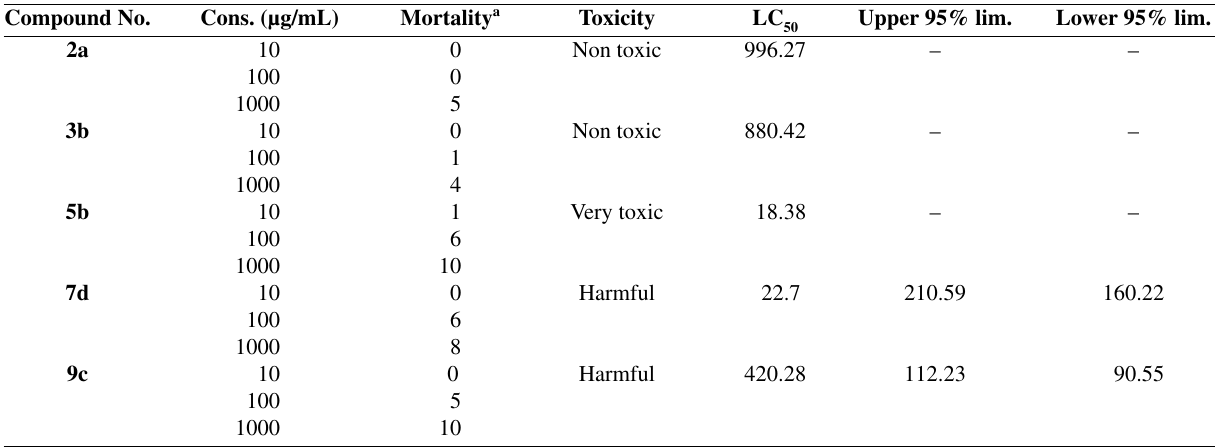
Table 2 . LC of compounds 2a , 3b , 5b , 7d and 9c against shrimp larvae 50 Compound No.